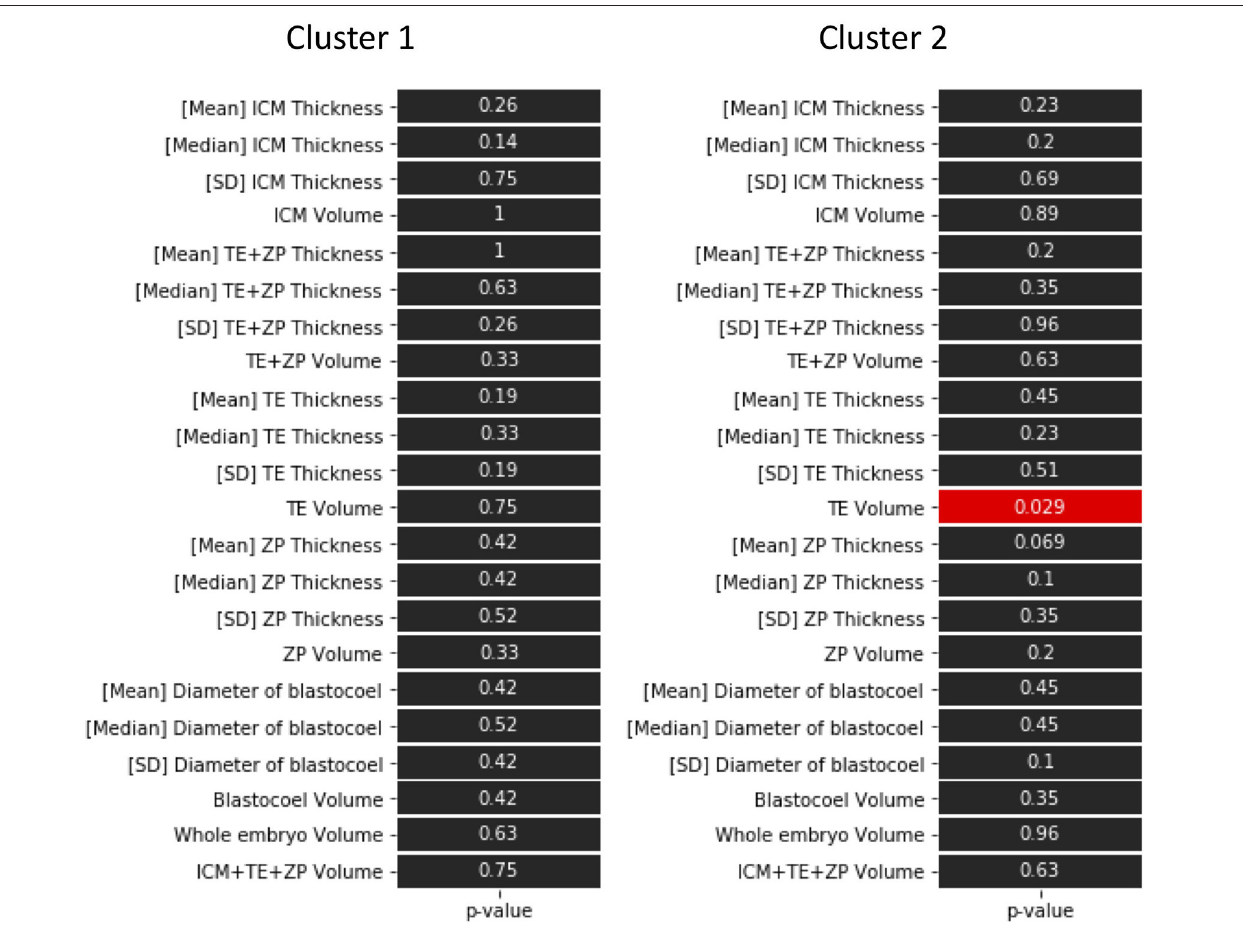
FIGURE 12 | P -values in the comparison of 22 parameters evaluated from the optical coherence tomography (OCT)-scanned 3D images of bovine blastocysts between pregnancy and non-pregnancy in each cluster (pregnancy: n = 15, non-pregnancy: n = 15). Statistical significance was analyzed using the Mann-Whitney U test. A value of p < 0.05 was considered statistically